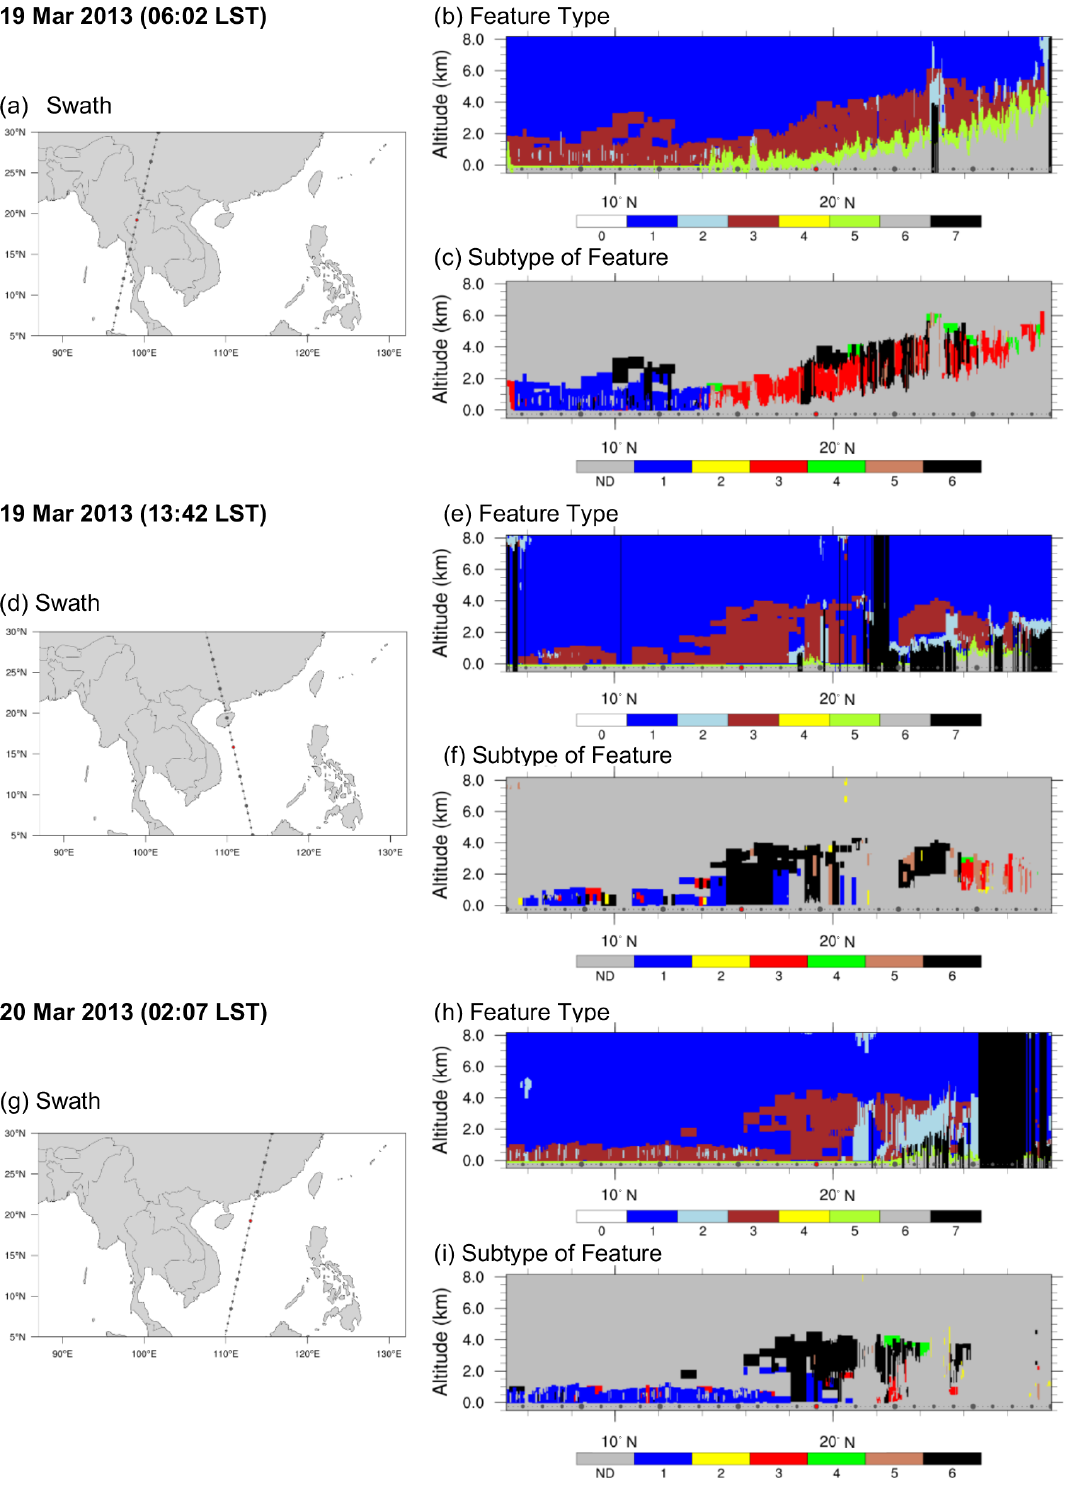
Figure 5. CALIOP vertical feature type and aerosol subtype during a continuous episode starting from (a–c) 19 March (06:02LST), (d– f) 19 March (13:42LST) and (g–i) 20 March (02:07LST). The corresponding position of the satellite swath is marked in points of red and gray marked in (a, d, f) and altitude below 0km in (b, c, e, f, h, i) . Feature type: 0 – invalid, 1 – clear air, 2 – cloud, 3 – aerosol, 4 – strato, 5 – surface, 6 – subsurface, 7 – no signal; subtype of feature: ND – no data, 1 – marine, 2 – dust, 3 – polluted continental, 4 – clean continental, 5 – polluted dust, 6 –